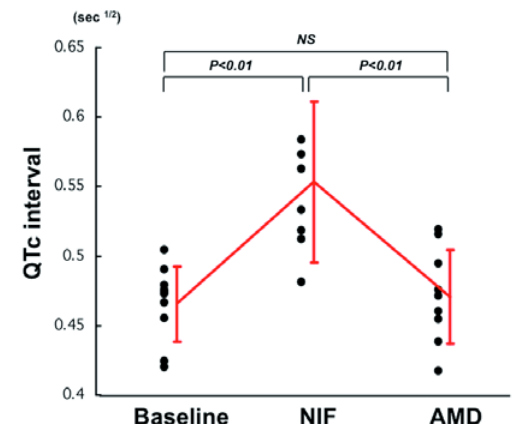
Figure 1. Effects of administration of nifekalant hydrochloride (NIF) and intravenous amiodarone (AMD) on QTc